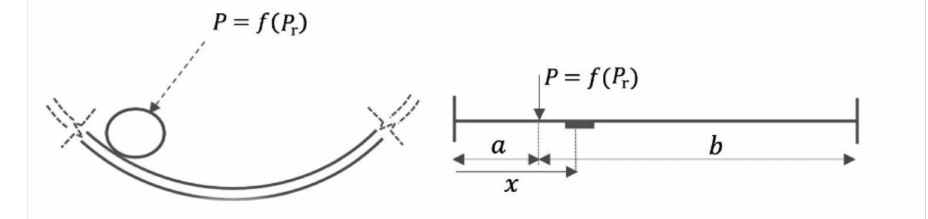
Figure 6. Beam model for a single-load case for estimation of the bearing outer ring deformation [23]: P is the load transmitted by a ball, P r is the load applied to the inner ring of the bearing, x is the sensor position, and a and b are the load positions relative to the left end and the right end of the beam,